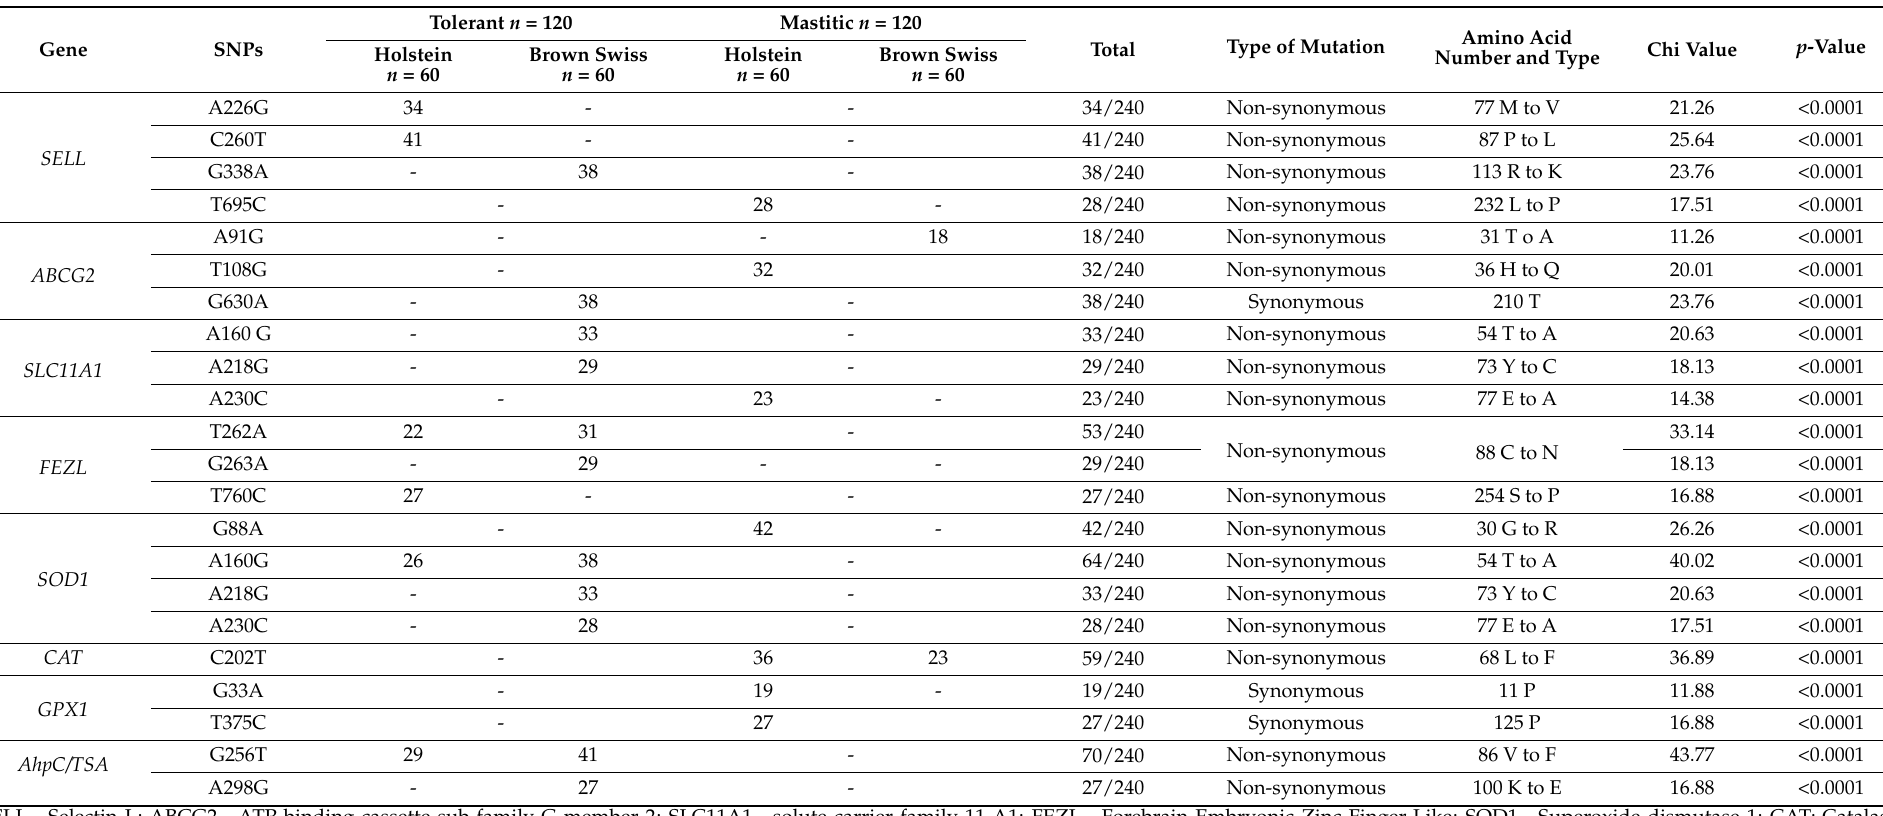
Table 3. Distribution of SNPs, type of mutation in investigated genes for mastitis tolerant and affected Holstein and Brown Swiss dairy